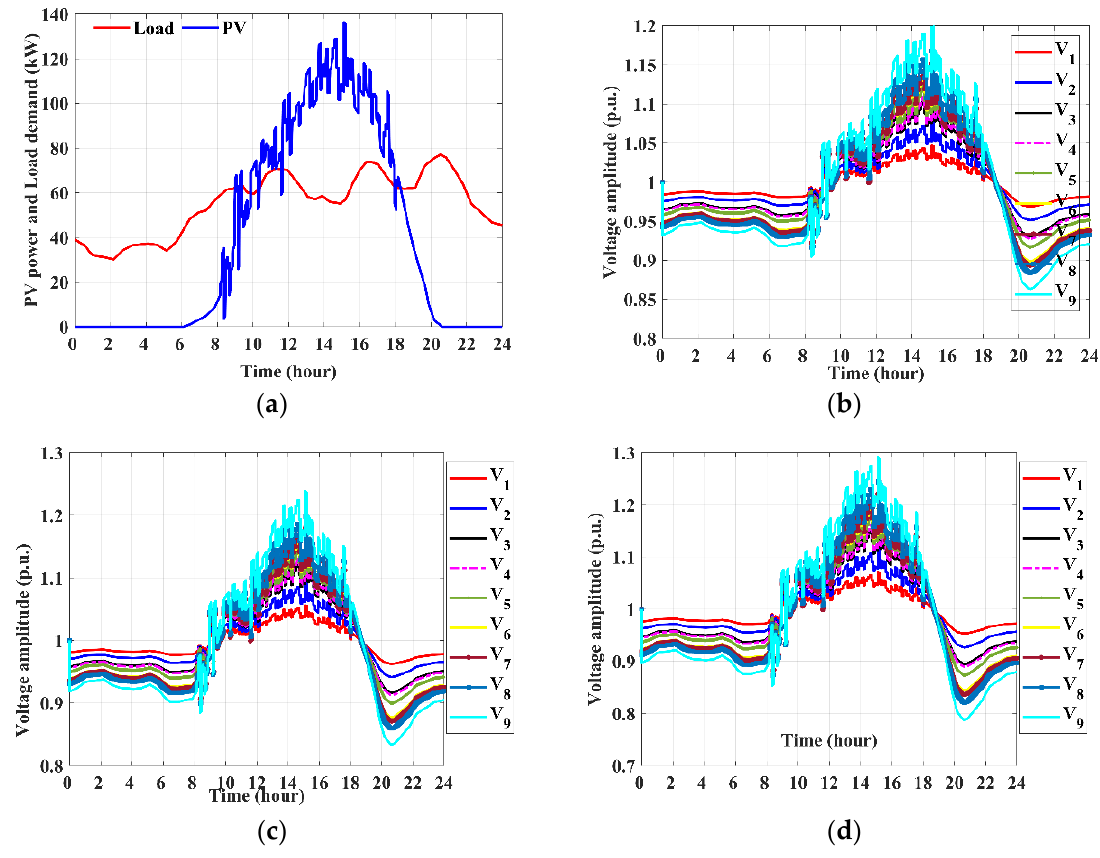
Figure 4. Node voltage fluctuation without regulation strategy: ( a ) Total PV power output and total load demand; ( b ) the fluctuation of node voltage amplitude; ( c ) the voltage amplitudes with 1.2 times the length of cables; ( d ) the voltage amplitudes with 1.5 times the length of cables.